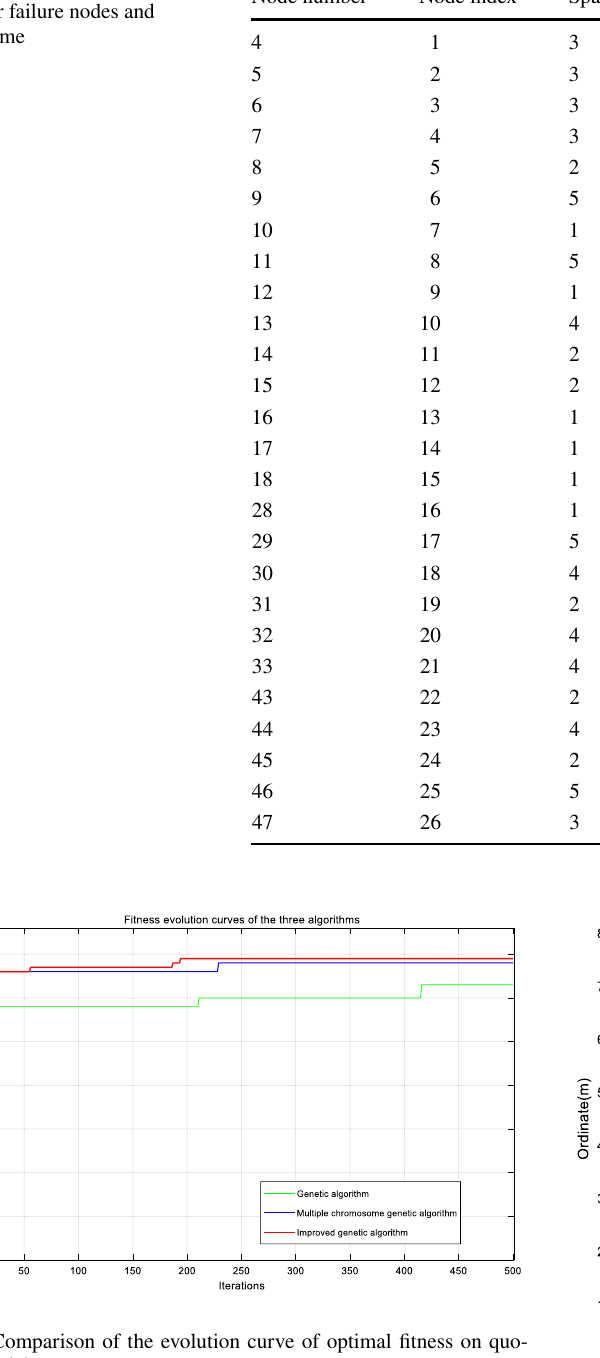
Fig. 8 Recovery strategy of classic genetic algorithm on quotient